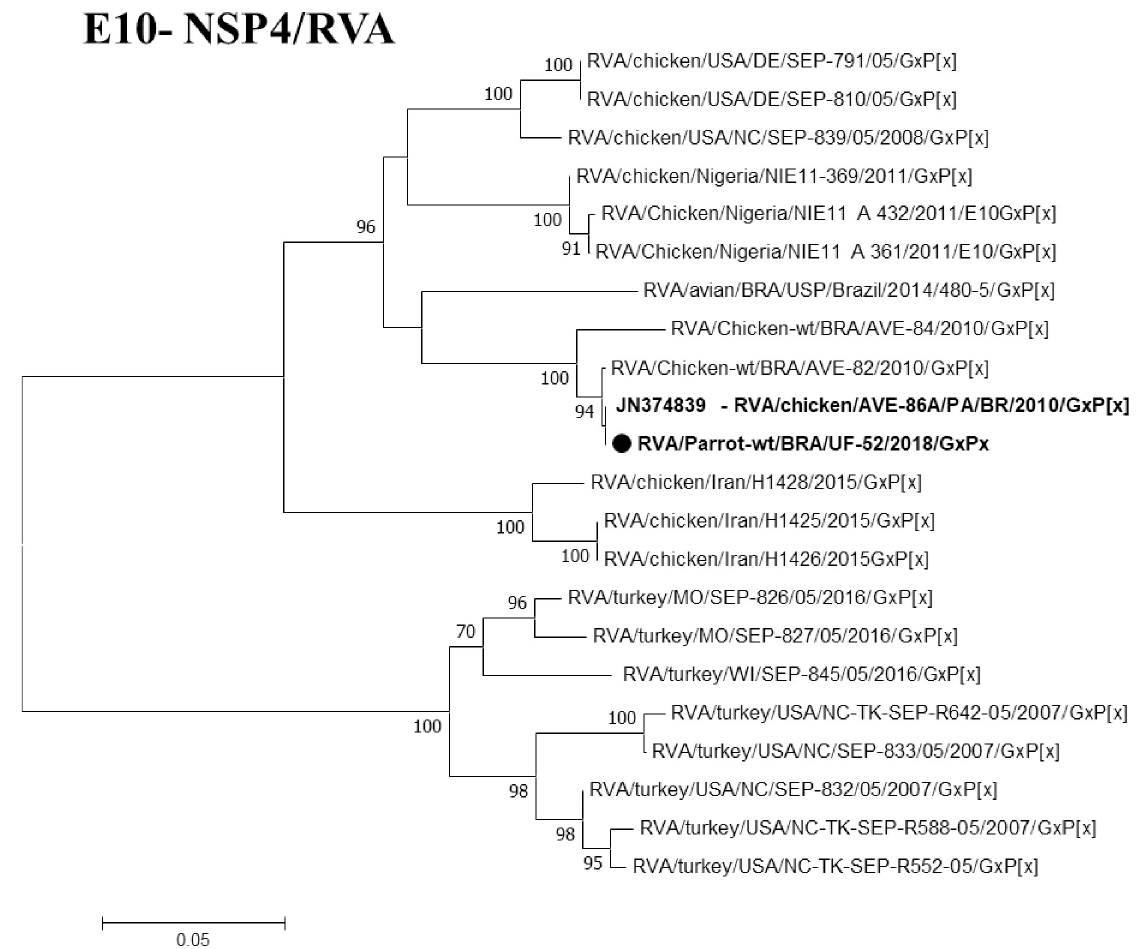
Fig 5. Phylogenetic tree based on the alignment of avian RVA NSP4 gene sequences. The sequence of this study is represents in bold, and the black color depicts the birds. The numbers next to the nodes indicate bootstrap values > 70.